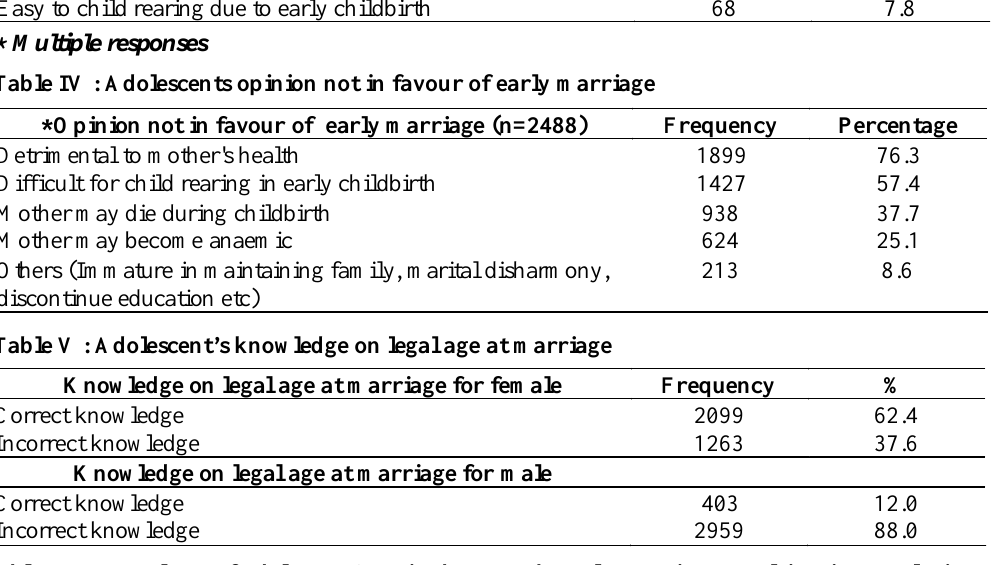
Table III : Adolescents opinion in favour of early marriage *Opinion in favour of early marriage (n=874) Less chance to go astray Very difficult to get married at later ages Less troublesome to the parents